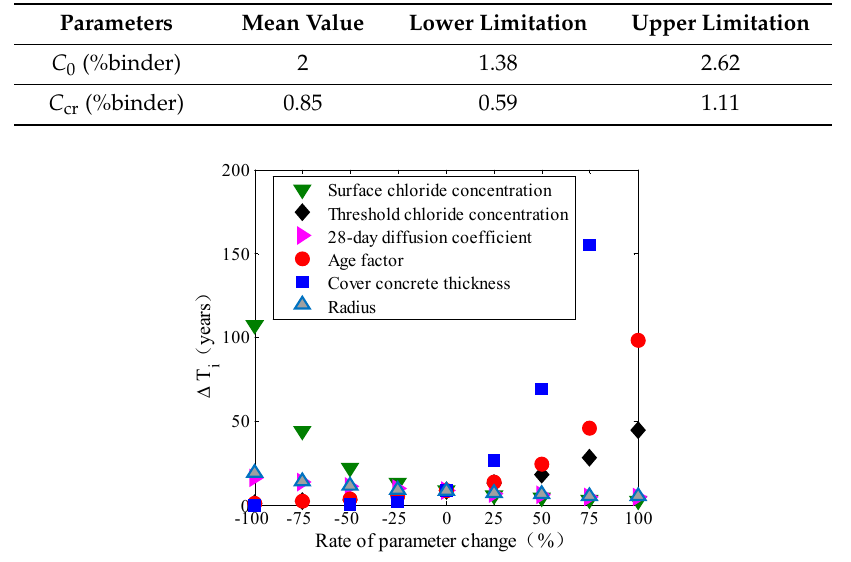
Figure 11. The sensitivity analysis of model parameters for this difference Δ T i.